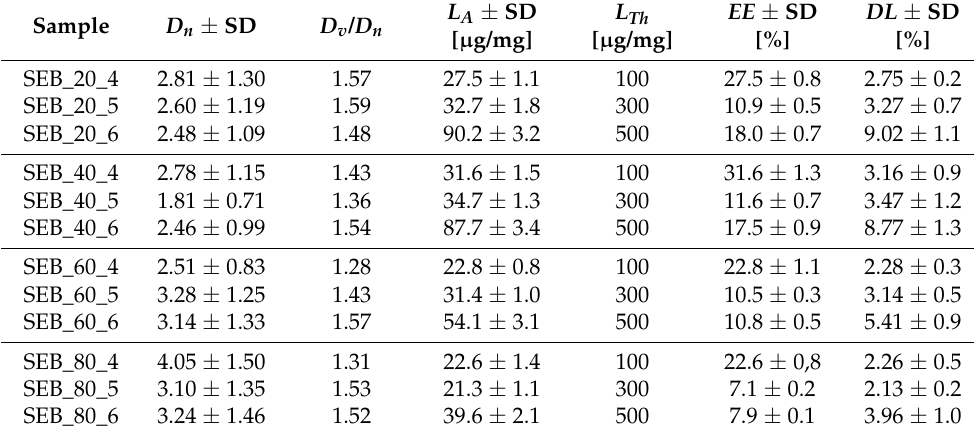
Table 7. Microsphere size, actual and theoretical loading, encapsulation efficiency and drug loading of small rifampicin-loaded